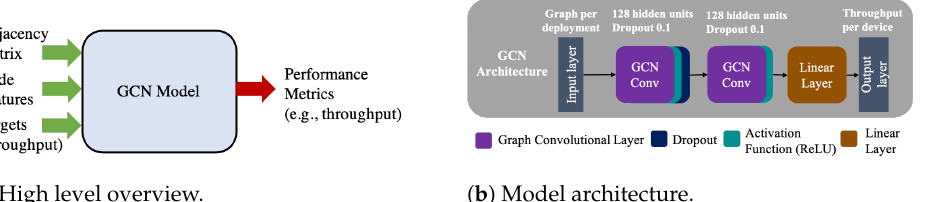
Figure 3. Summary of our GNN model. A high level overview is presented on the left, while the model architecture is presented on the